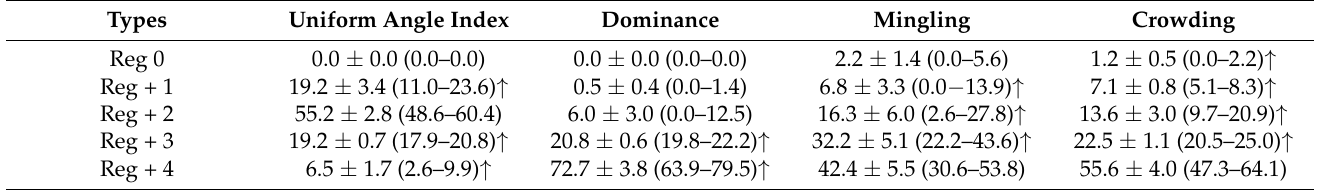
Table 4. The proportion statistics of change types in recruitment process (%).